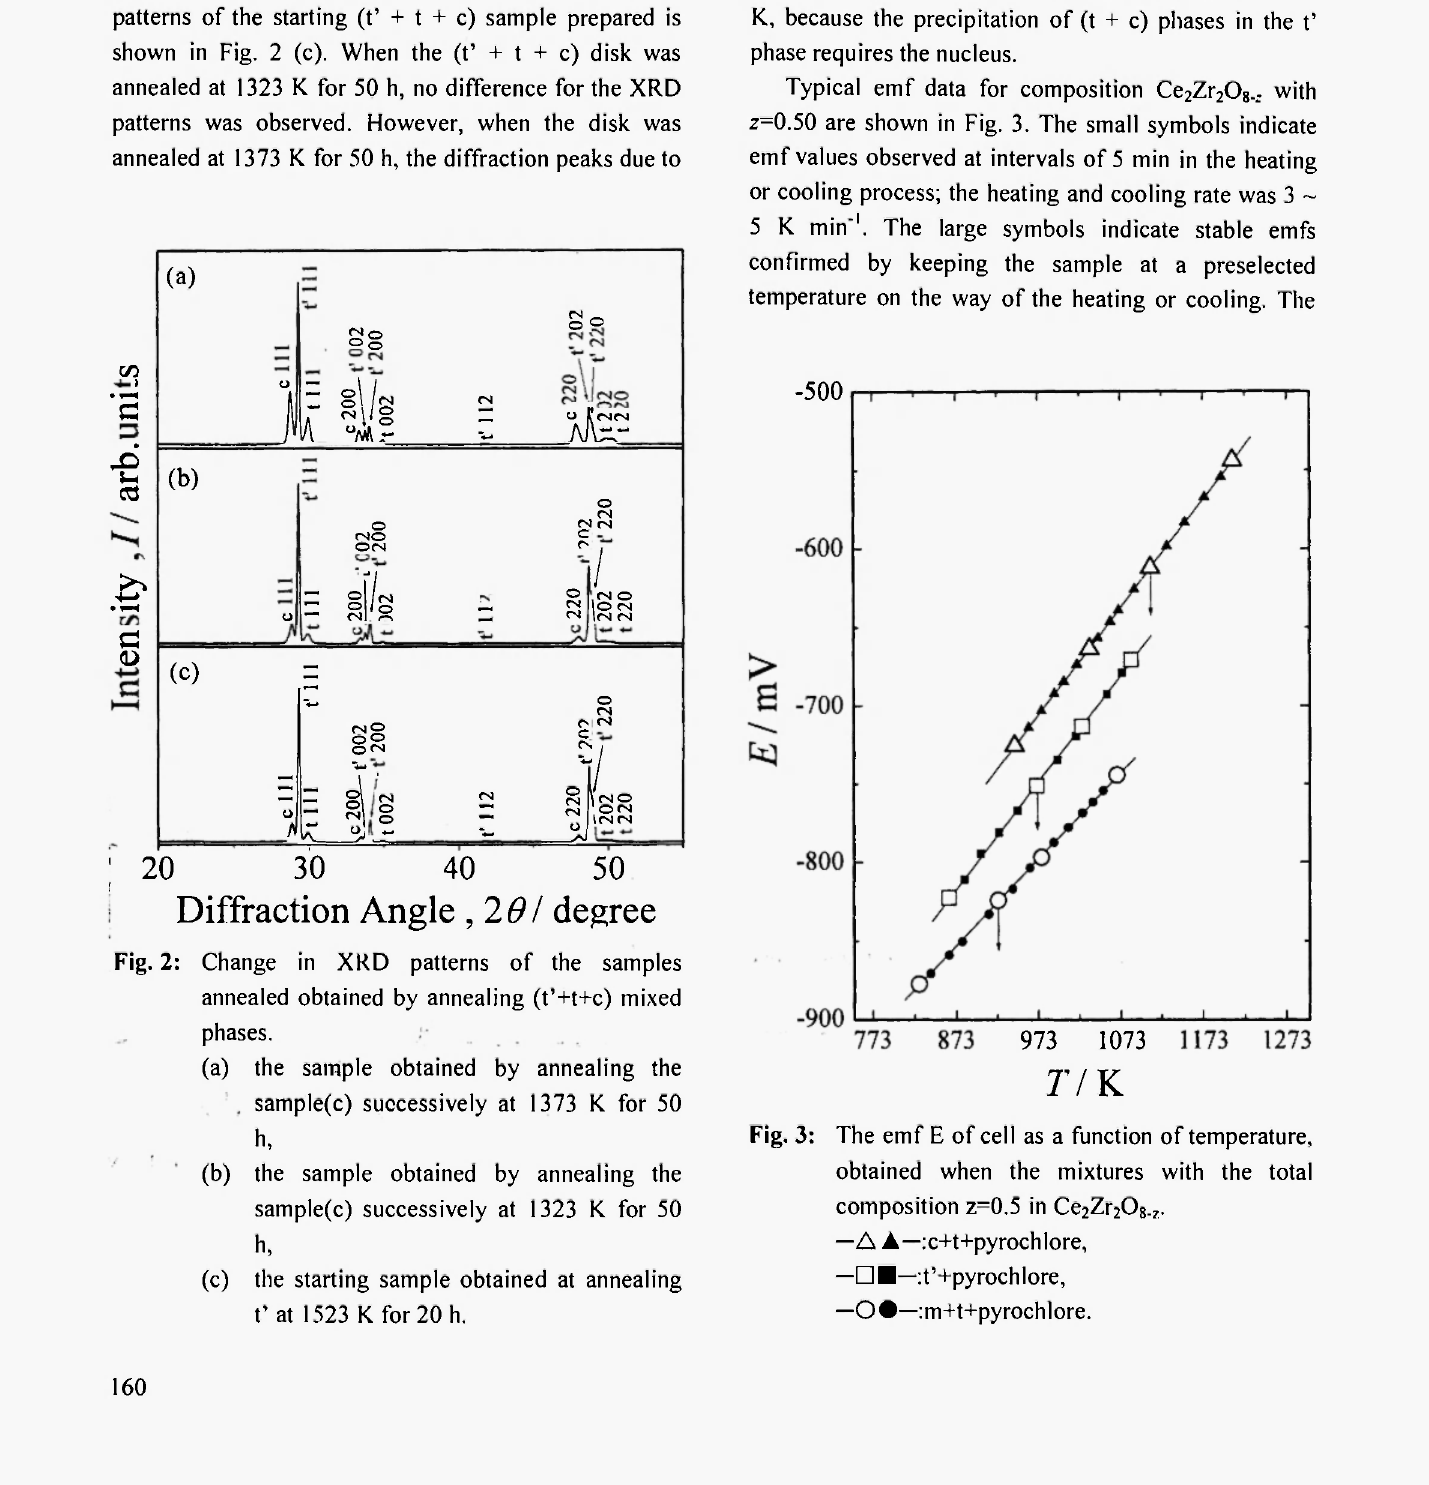
Fig. 2: Change in XRD patterns of the samples